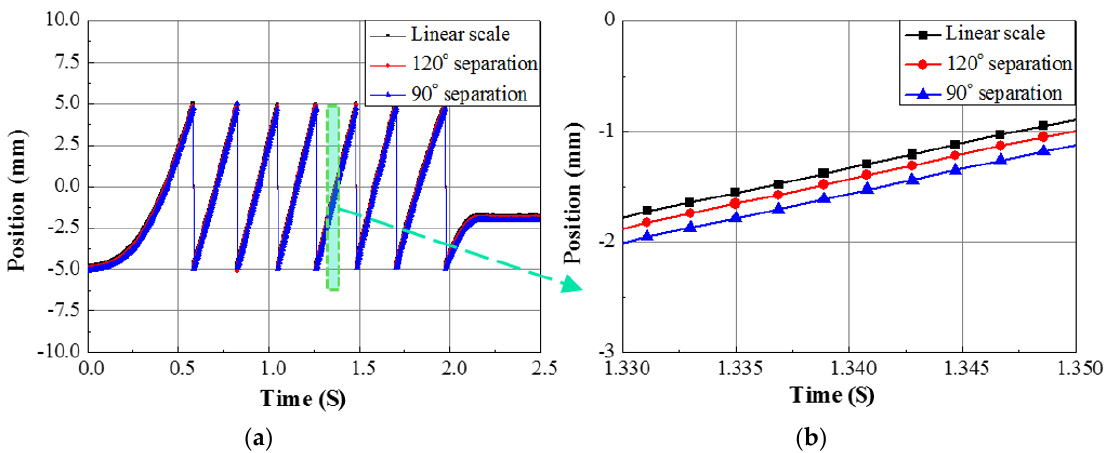
Figure 13. ( a ) Mover position of the linear motor detected using the sensor module and the comparison of the position data with that of the linear scale; ( b ) Deviation of the sensor module data with that of the linear scale [7].